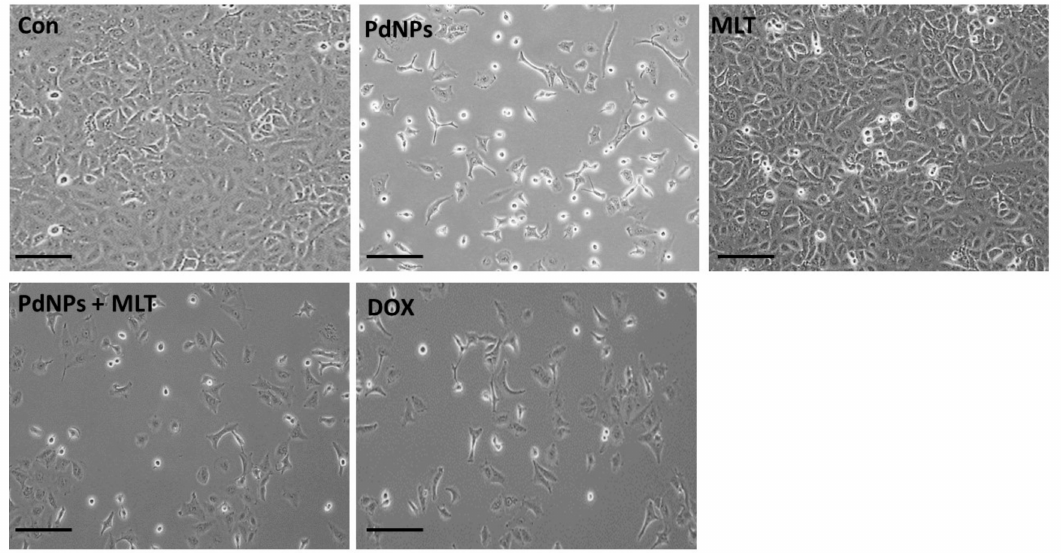
Figure 5. Combining PdNPs with MLT altered cell morphology in A549 cells. A549 cells were incubated with PdNPs (2.5 µ M), MLT (0.75 mM), PdNPs and MLT (2.5 + 0.75 mM), or DOX (5.0 µ M) for 24 h. Cell morphology was determined microscopically. Scale bar: 100 µ